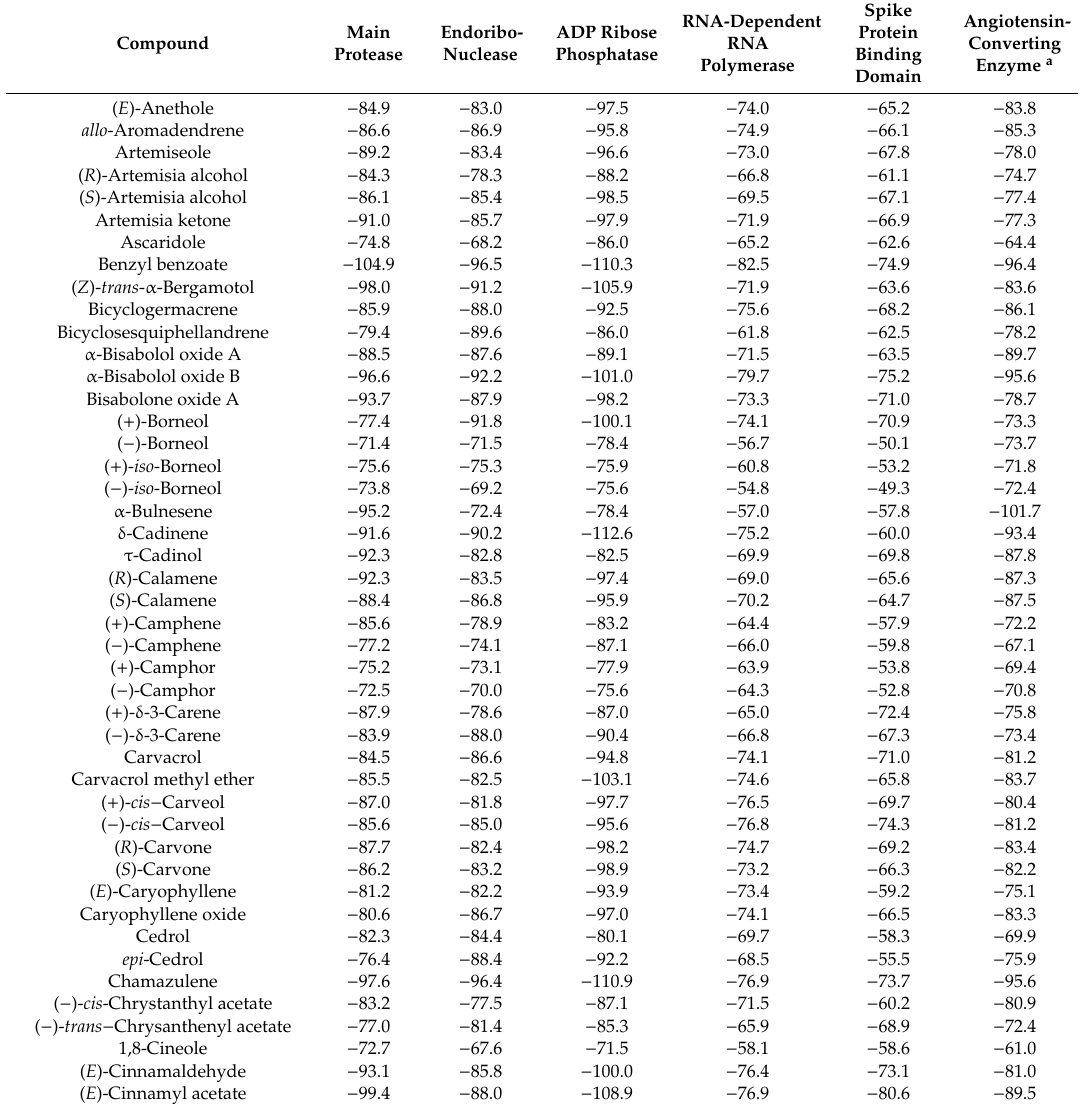
Table 3. Docking scores, normalized for molecular weight (DS norm , kJ / mol), of essential oil components with severe acute respiratory syndrome coronavirus 2 (SARS-CoV-2) molecular targets. Compound